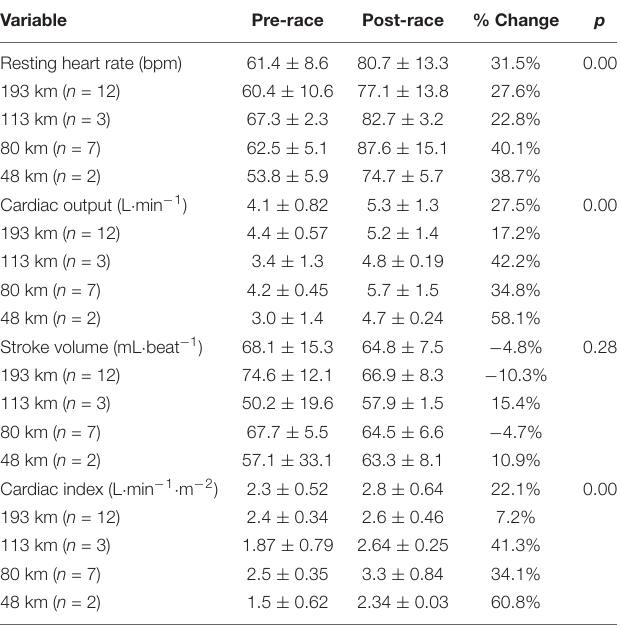
TABLE 2 | Pre- and post-race resting cardiac function.